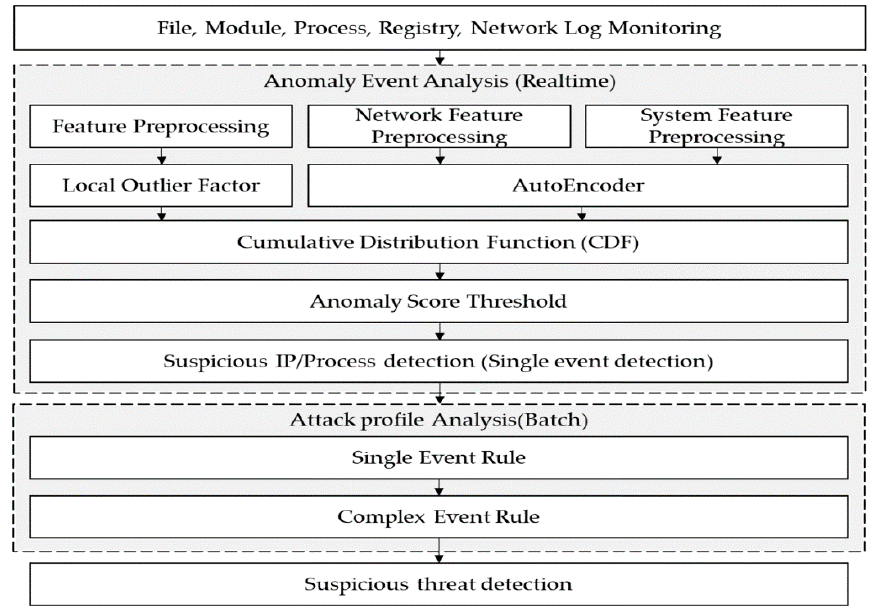
Figure 5. Overall structure of the proposed model.